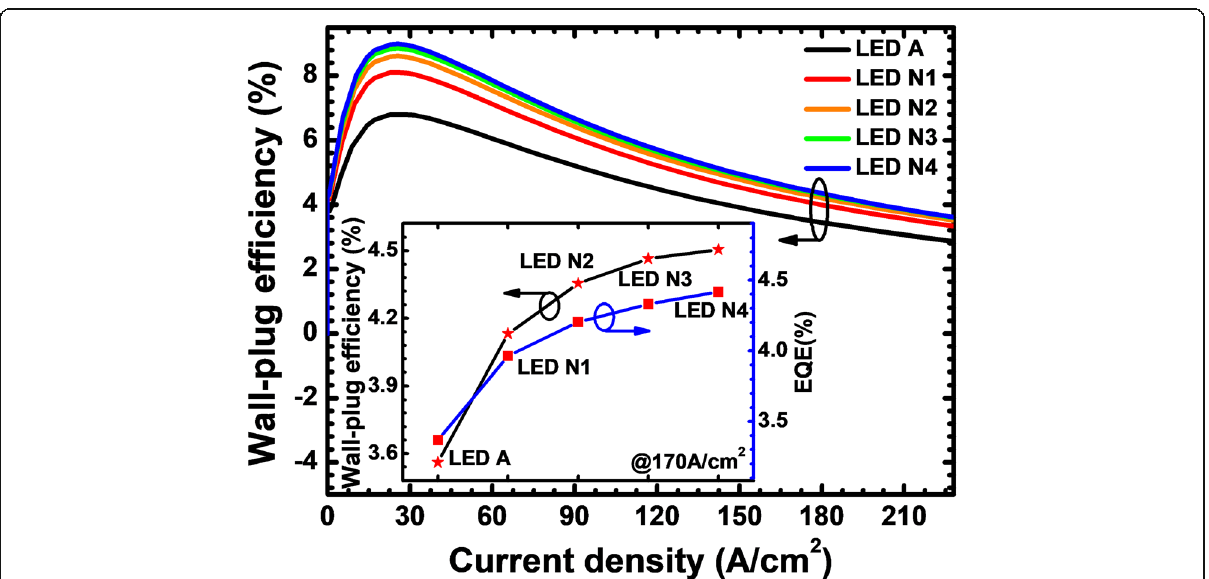
Fig. 14 WPE as a function of the injection current for LEDs A, N1, N2, N3, and N4. Inset figure shows the WPE and EQE for LEDs with various number of PNP-AlGaN junction at the current density of 170 A/cm 2